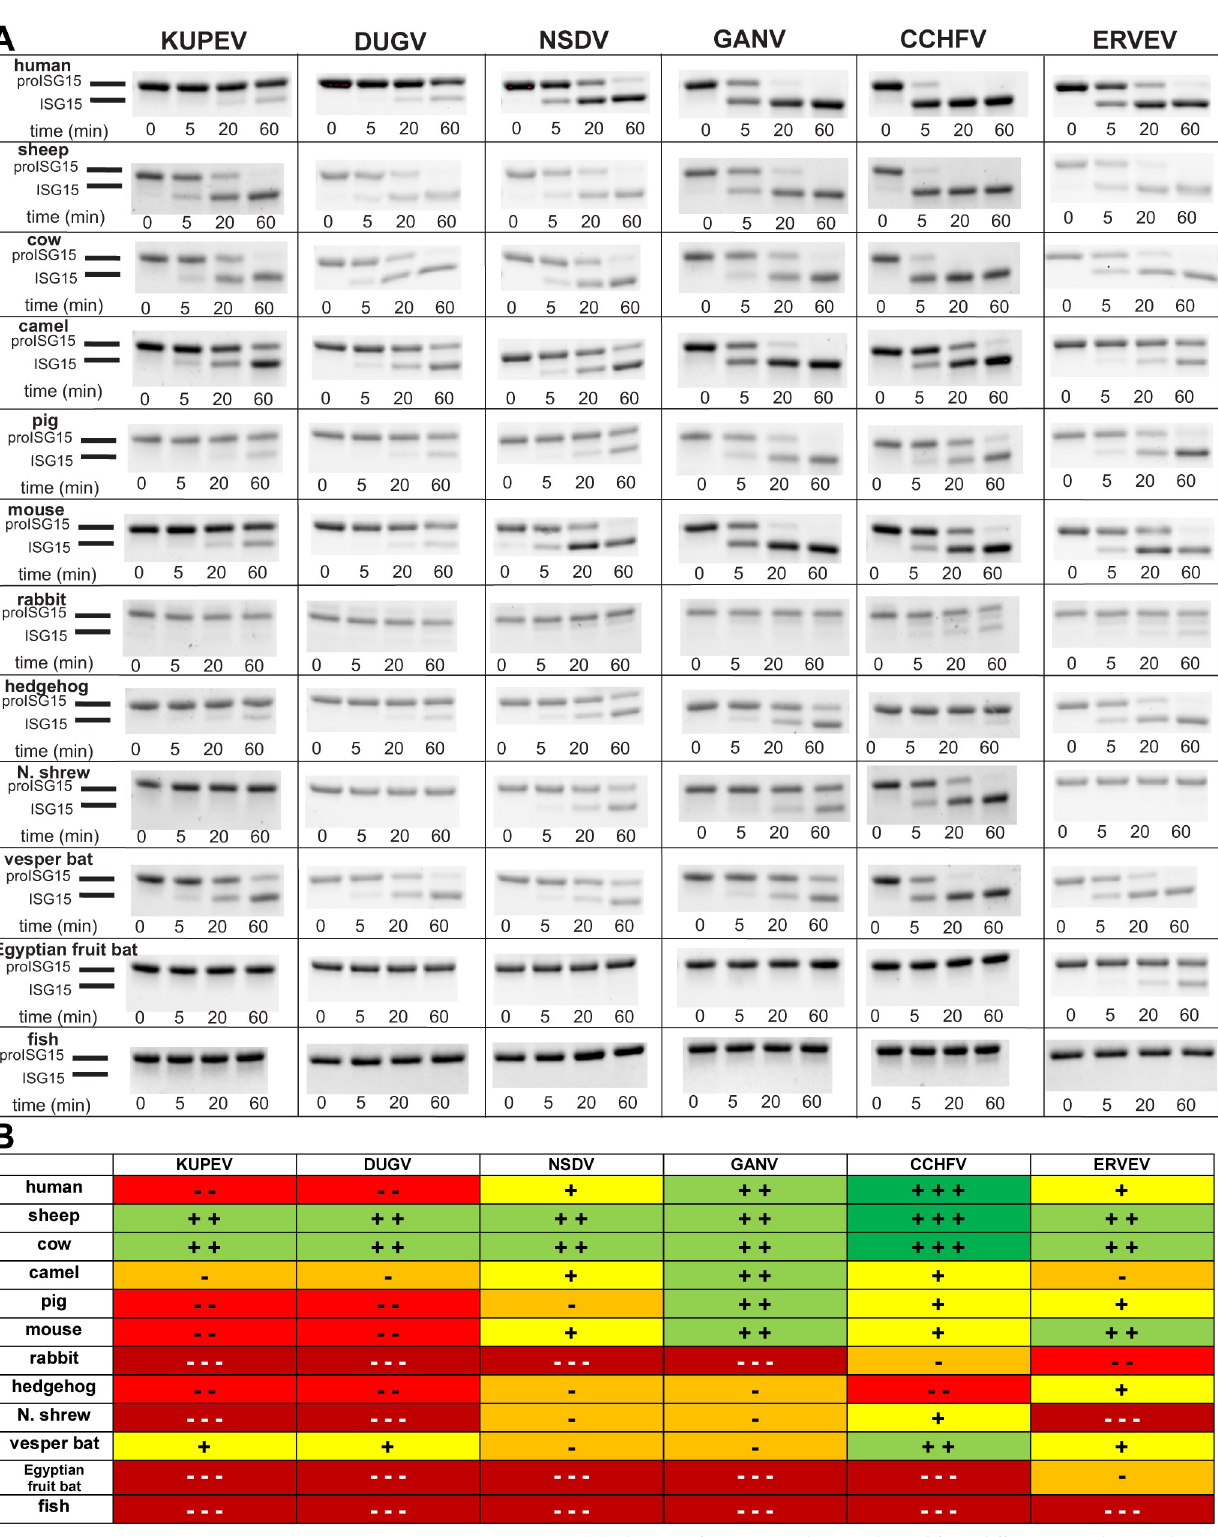
Fig 2. Activity of nairovirus OTUs for proISG15 from different species. (A) Cleavage of proISG15 substrates derived from different animal species by nairovirus OTUs. Each OTU was present at a 20 nM concentration and run against 10 μ M of each ISG15 at 37˚C. Samples were taken at the indicated timepoints and the reaction quenched in 2x Laemmli sample buffer followed by boiling at 98˚C for five minutes. SDS-PAGE analysis was performed using